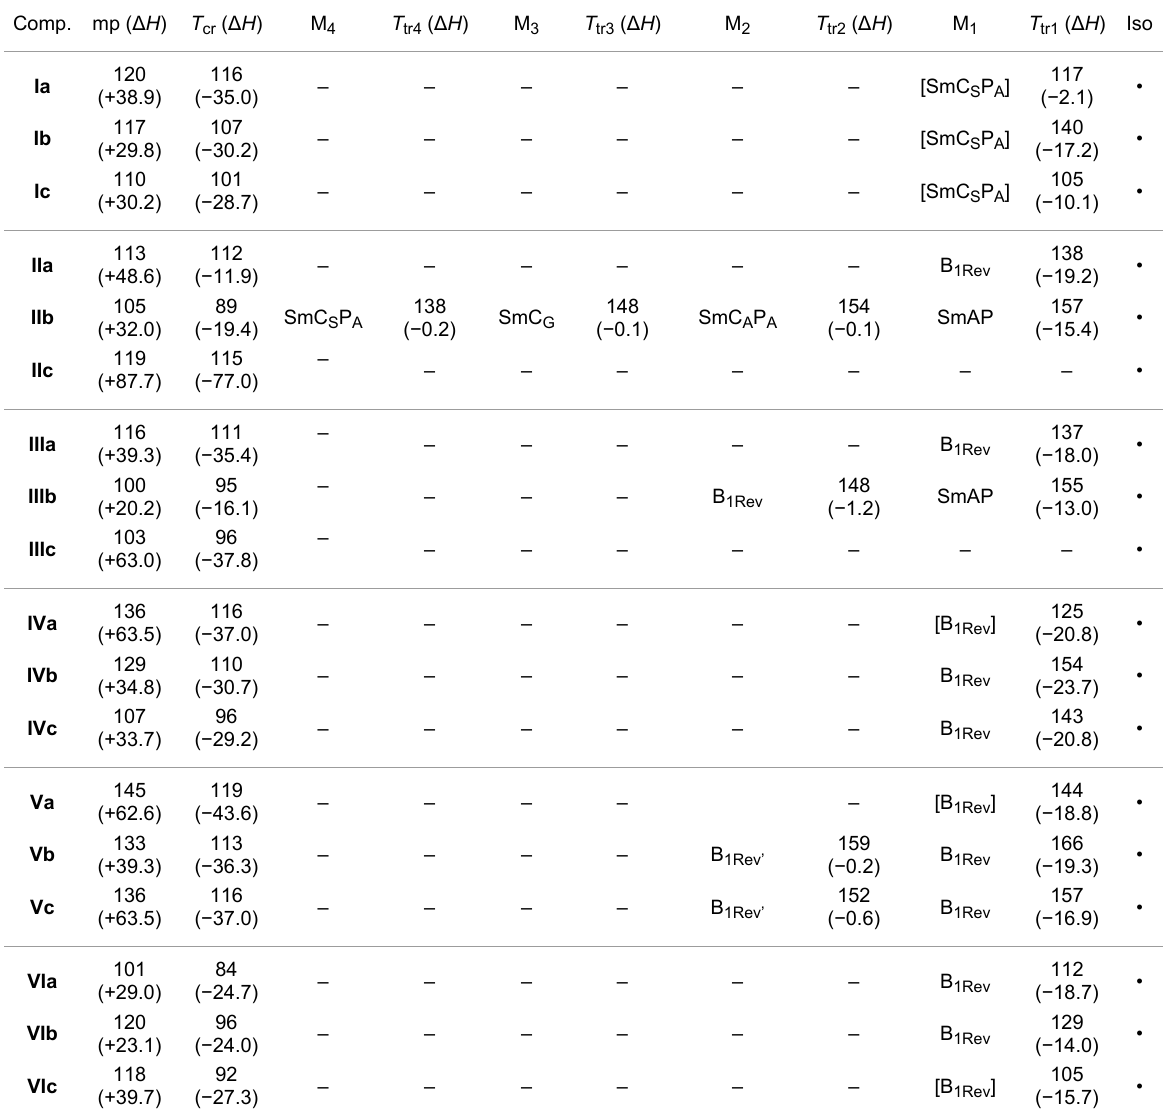
Table 1: Melting point, mp., phase-transition temperatures, T tr , in °C, and corresponding enthalpies, Δ H , in kJ mol –1 (in parenthesis) are obtained from the DSC measurements. The mp was detected in the second heating and T tr in the second cooling run at a rate 5 K/min. Monotropic phases are presented in square brackets. LC mesophases and their identification are described in the